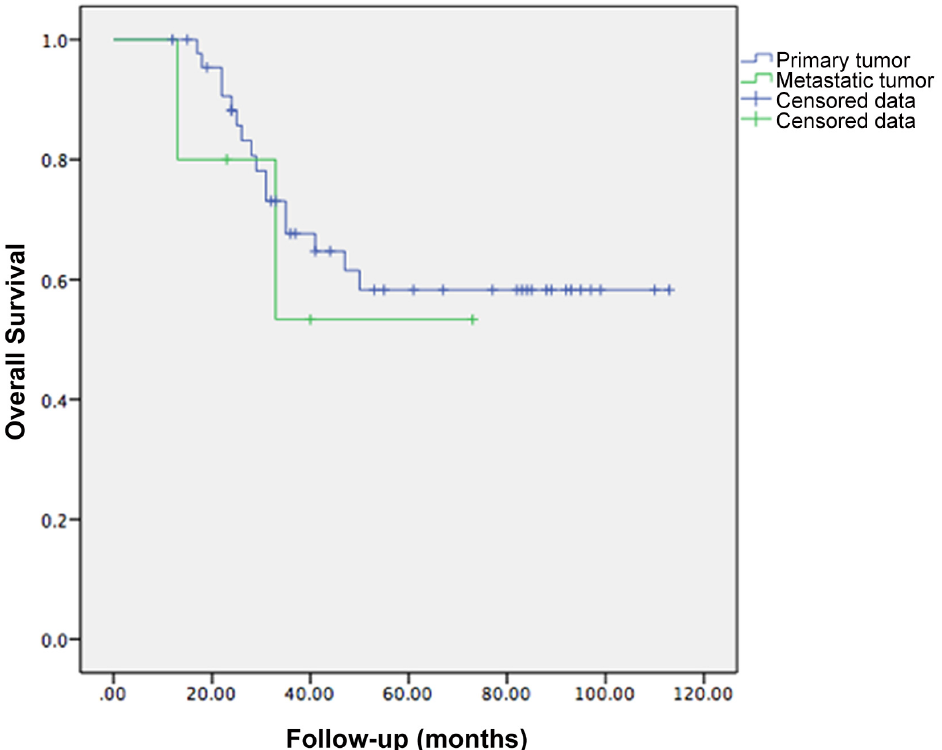
Fig 3. A Kaplan-Meier survival curve showing no significant difference between overall survival of primary and metastatic tumors (p =